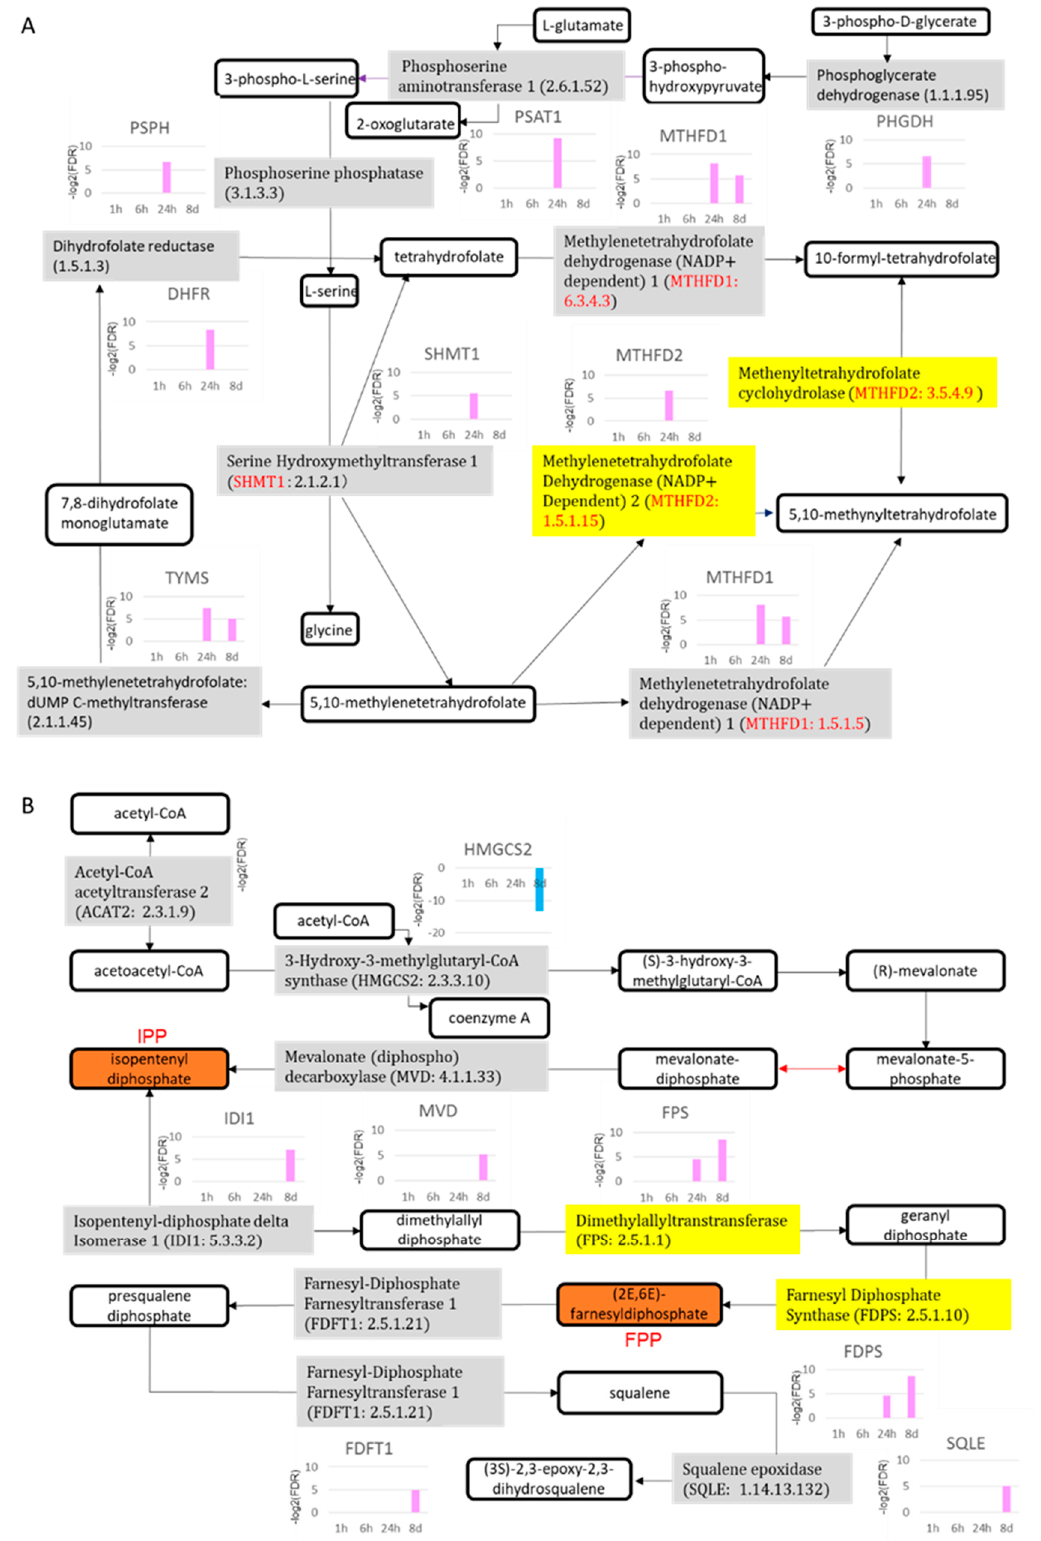
Figure 7. Folate metabolic and cholesterol biosynthetic pathways. ( A ) Folate metabolic pathway; ( B ) cholesterol biosynthetic pathway. Gray and yellow are enzymes; others are biological products. 8d: 8 days.